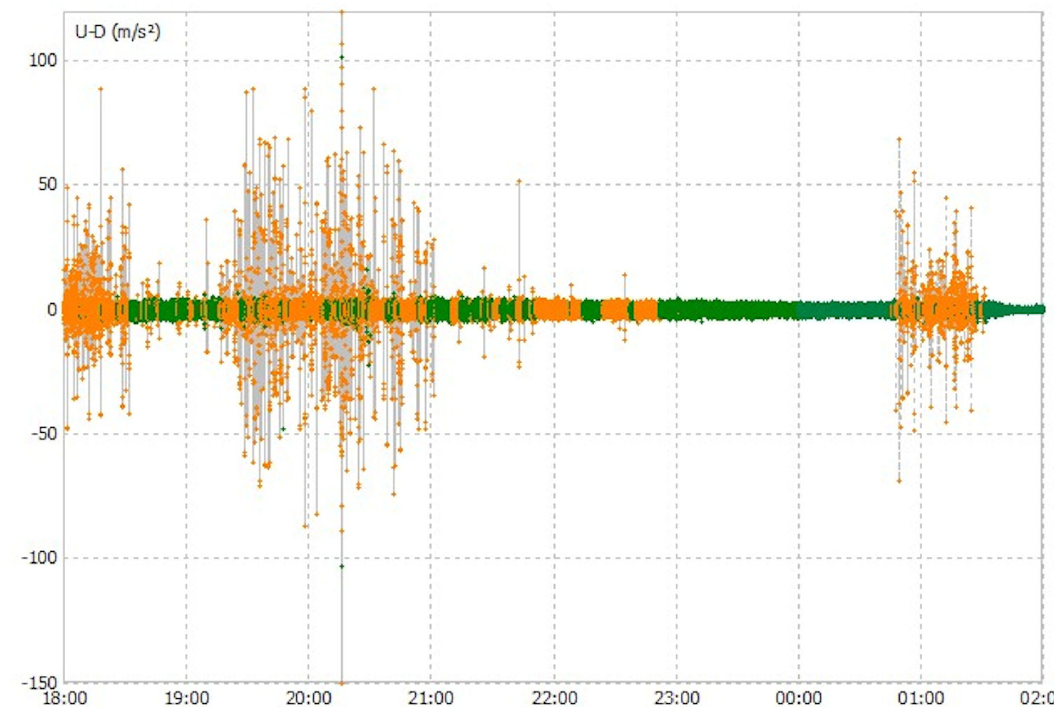
Figure 7. Buoy vertical accelerations during tidal cycle A; 18:00 28 August–02:00 29 August. Fixed solutions (Q1) are shown in green, and float solutions (Q2) are shown in orange.